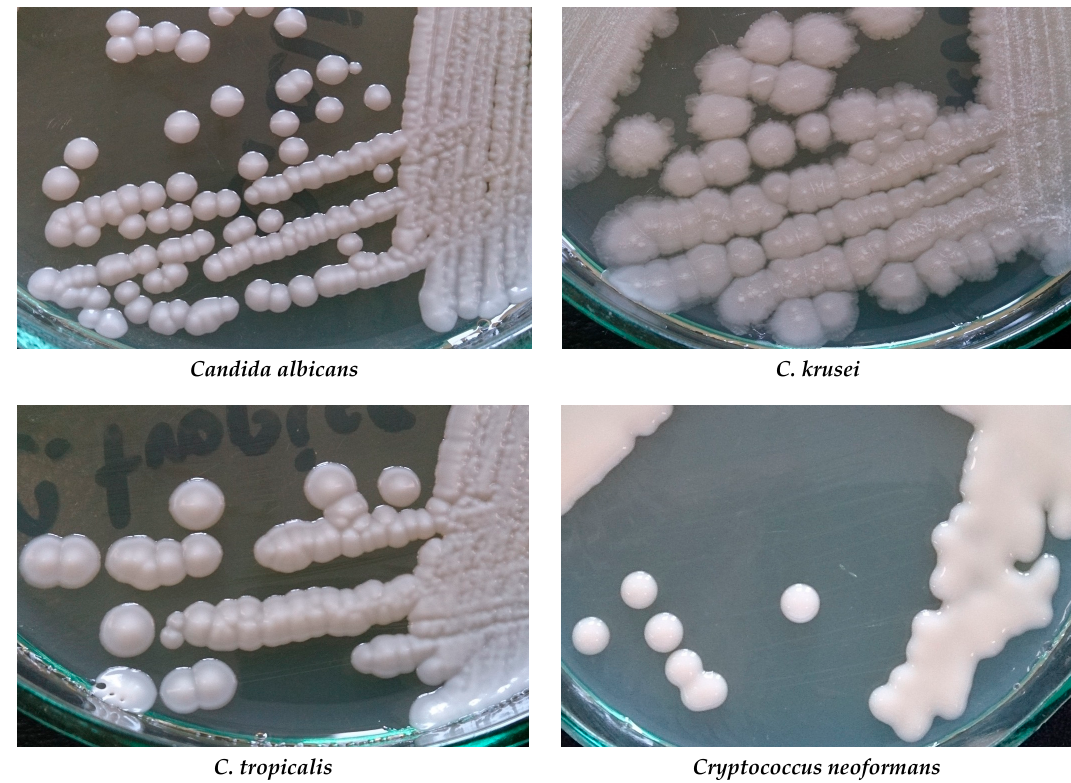
Figure 1. Cultures of selected yeast fungi on Sabouraud agar (Author of photos: Tomasz M. Karpi ń ski).